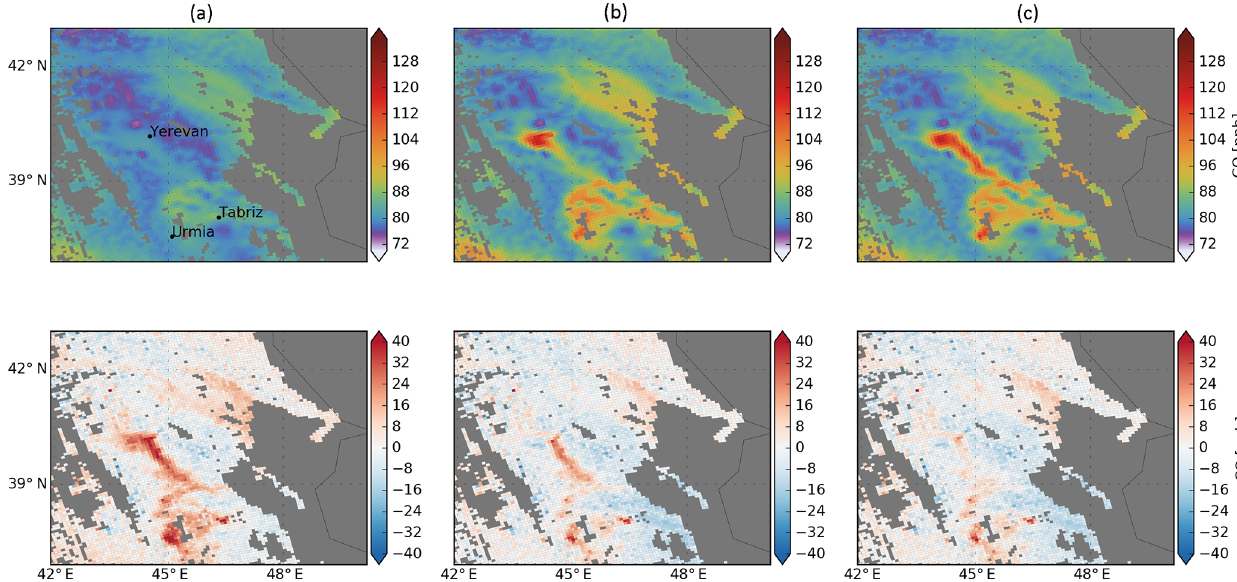
Figure 8. Comparison of TROPOMI CO and WRF (top row: WRF simulation; lower row: difference, TROPOMI − WRF) on 17 Decem- ber 2017 09:56UTC above Armenia. (a) WRF run with EDGAR emissions. (b) WRF run with adjusted emissions for Yerevan, Tabriz, and Urmia. (c) WRF run with adjusted emission of Yerevan, Tabriz, and Urmia and the traffic route near